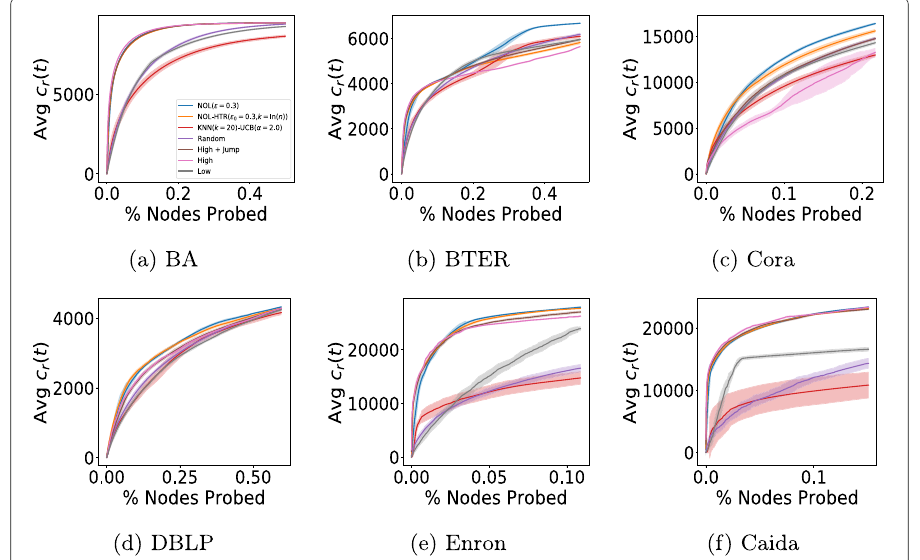
Fig. 9 Results of running NOL* algorithms on the same networks as Fig. 3, but starting from initial samples using random walk with jump sampling rather than node sampling with induction. Results are similar to those presented in the main text. In general, the performance of NOL is more consistent on random walk samples, while the performance of NOL-HTR is approximately the same or slightly worse (e.g.